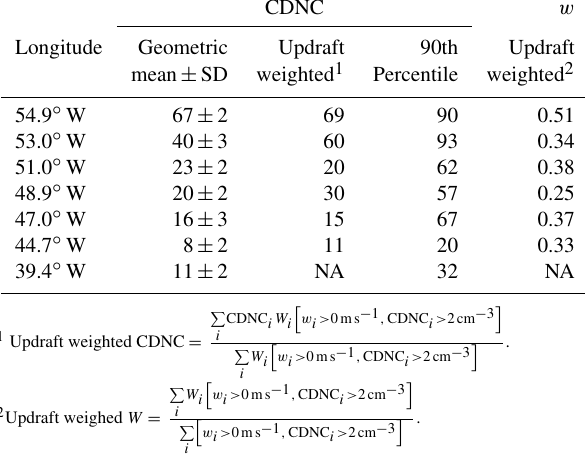
Table 1. In-cloud leg measurements of CDNC (cm − 3 ) and updraft velocity ( w , ms − 1 ) from the C130 flight on 17 September 2017 (Fig. 3). Cases when updraft measurements are not available for calculations are indicated in the table as NA. CDNC